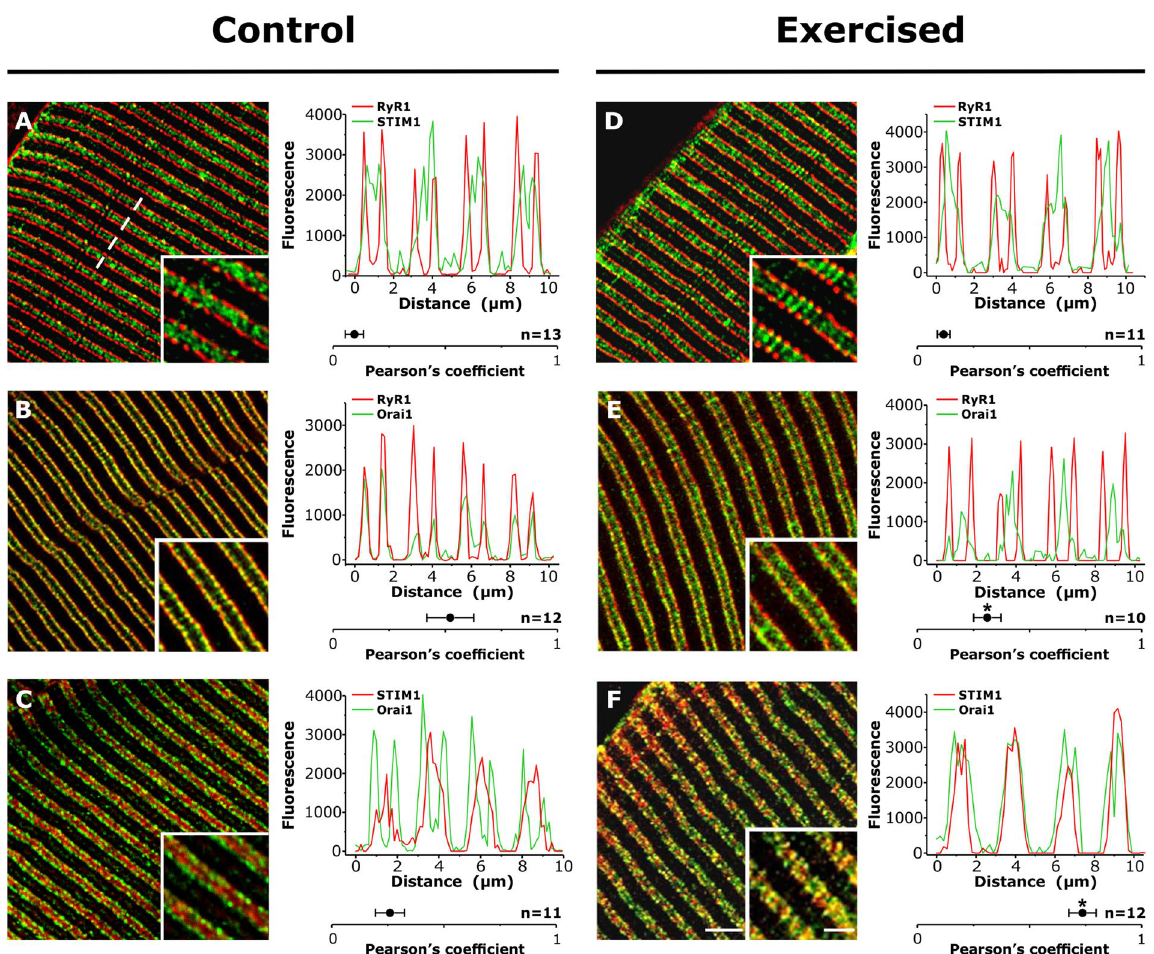
Figure 3. Co-localization between STIM1 and Orai1, low in control samples, increases significantly following exercise. Representative immunofluorescence images obtained from EDL fibers double-labeled for RyR1- STIM1 ( A and D ), RyR1-Orai1 ( B and E ), and STIM1-Orai1 ( C and F ). Each panel also contains a fluorescence intensity profile along 4 sarcomeres (see dashed line in A ) and the Pearson’s correlation coefficient value, a measure of covariance of pixel intensities, given as the mean ± SEM; * p < 0.01, compared to fibers from control mice. Numbers in figure (n) indicate the number of images analyzed. Scale bar: 2.5 µ m (insets: 1 µ